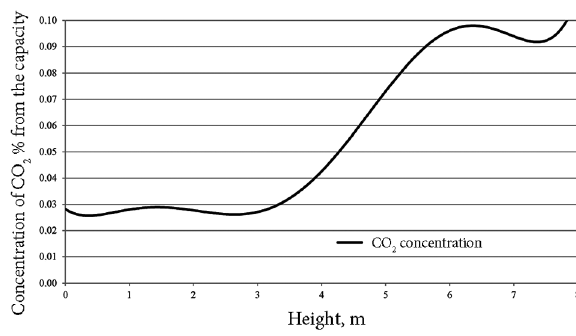
Figure 9. Modification of the concentration of CO 2 at the height of a winter